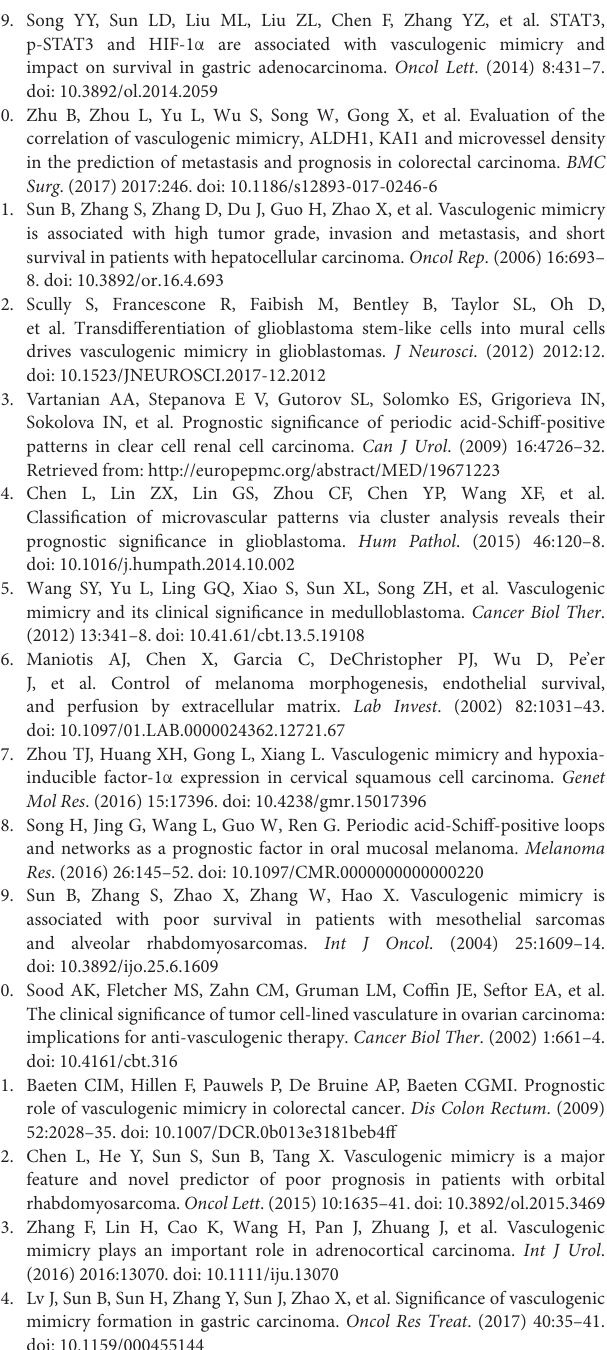
Supplementary Table SIII | Summary of the literature presenting mechanisms of action for vasculogenic mimicry. To be considered to represent a valid mechanism of VM formation the publications had to include the criteria of in vivo and/or in vitro characterization of 2-A, 3-A, 4-A, 2-B, 3-B or 4-B; or 5-Y, 6-Y, 7-Y, 8-Y, 9-Y or W-Y. In vivo model: Y = Yes; N = No. In vitro model: Y = Yes; N = No. In vivo characterization: 1 = H&E/PAS only; 2 = H&E/PAS-CD31; 3 = H&E/PAS-CD34; 4 = Other (leptin marker, laminin marker, electron microscopy, etc); A = Lumen containing structure only; B = Lumen containing structure with red blood cells;